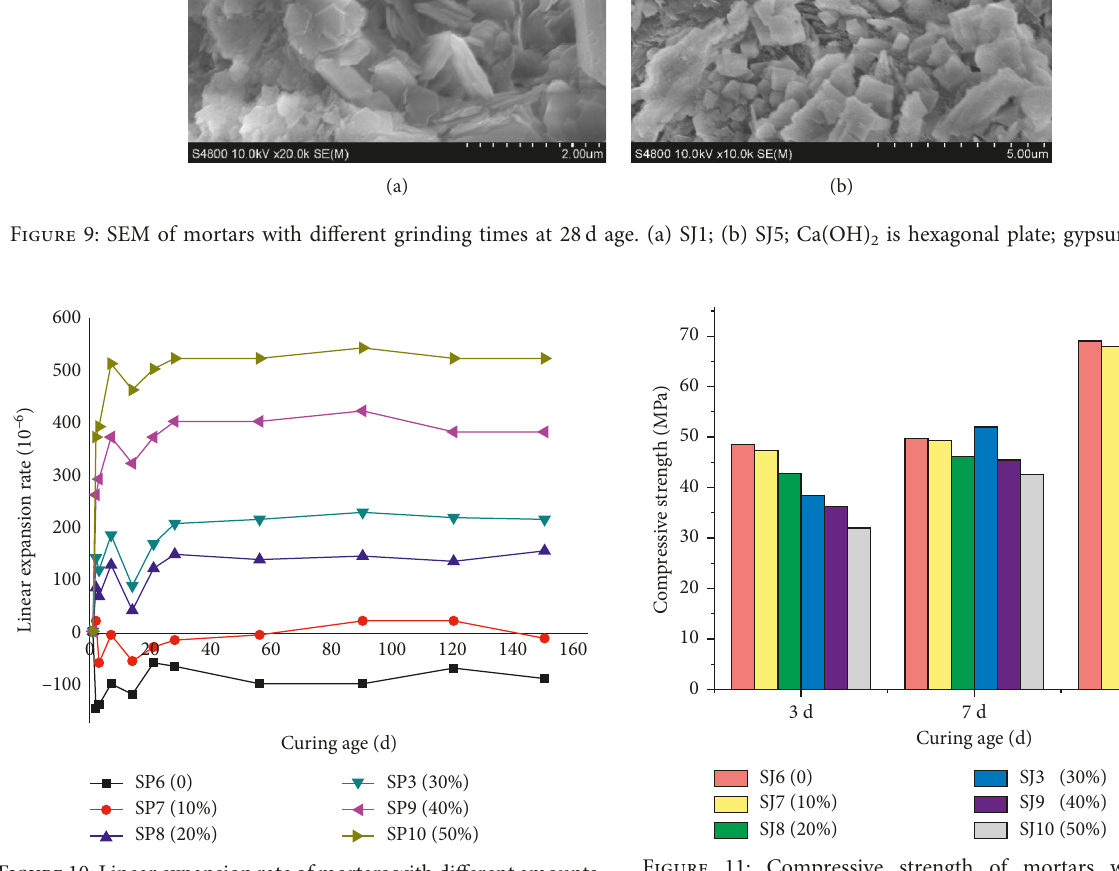
Figure 10: Linear expansion rate of mortars with different amounts of slag.